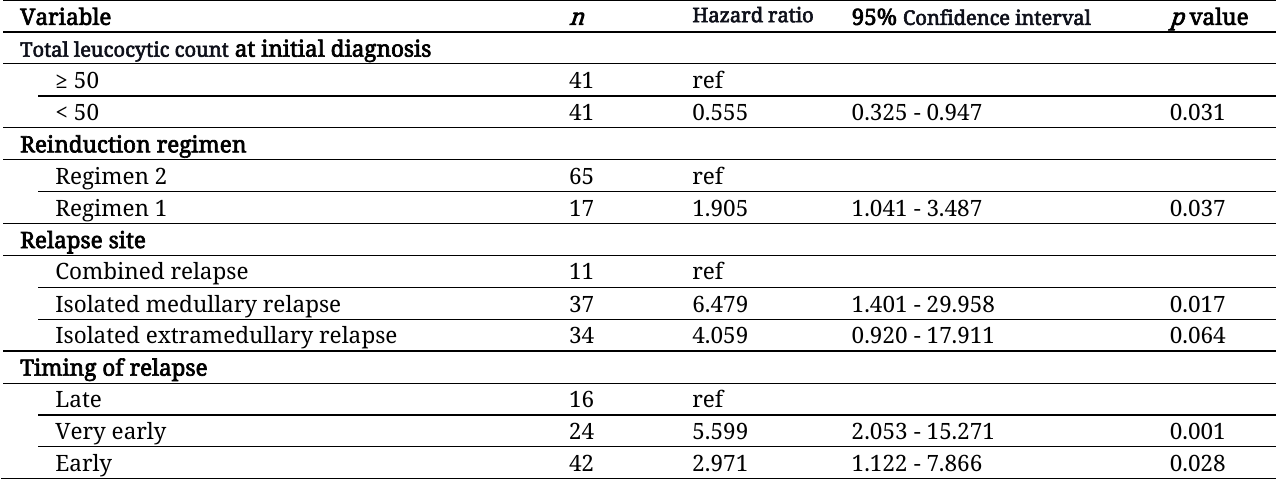
Table 4: Multivariate Cox regression analysis of event free survival of 82 children with first acute lymphoblastic leukemia